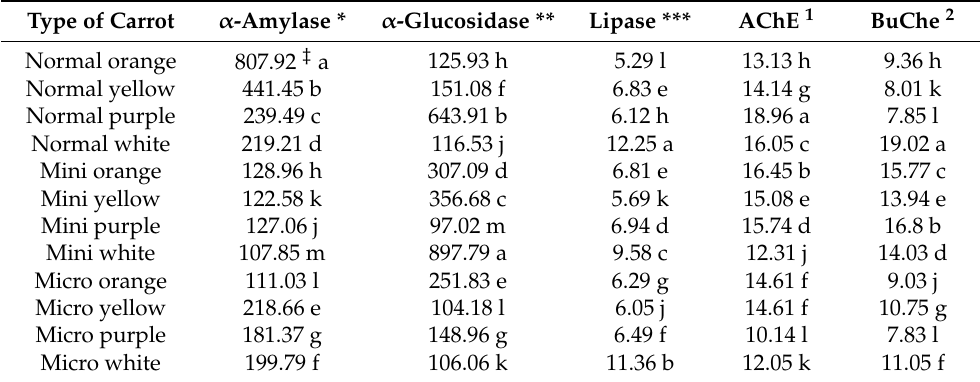
Table 4. In vitro inhibition activity ( α -amylase, α -glucosidase, pancreatic lipase, acetylcholinesterase, butyrylcholinesterase (IC 50 , mg/mL) of different carrot